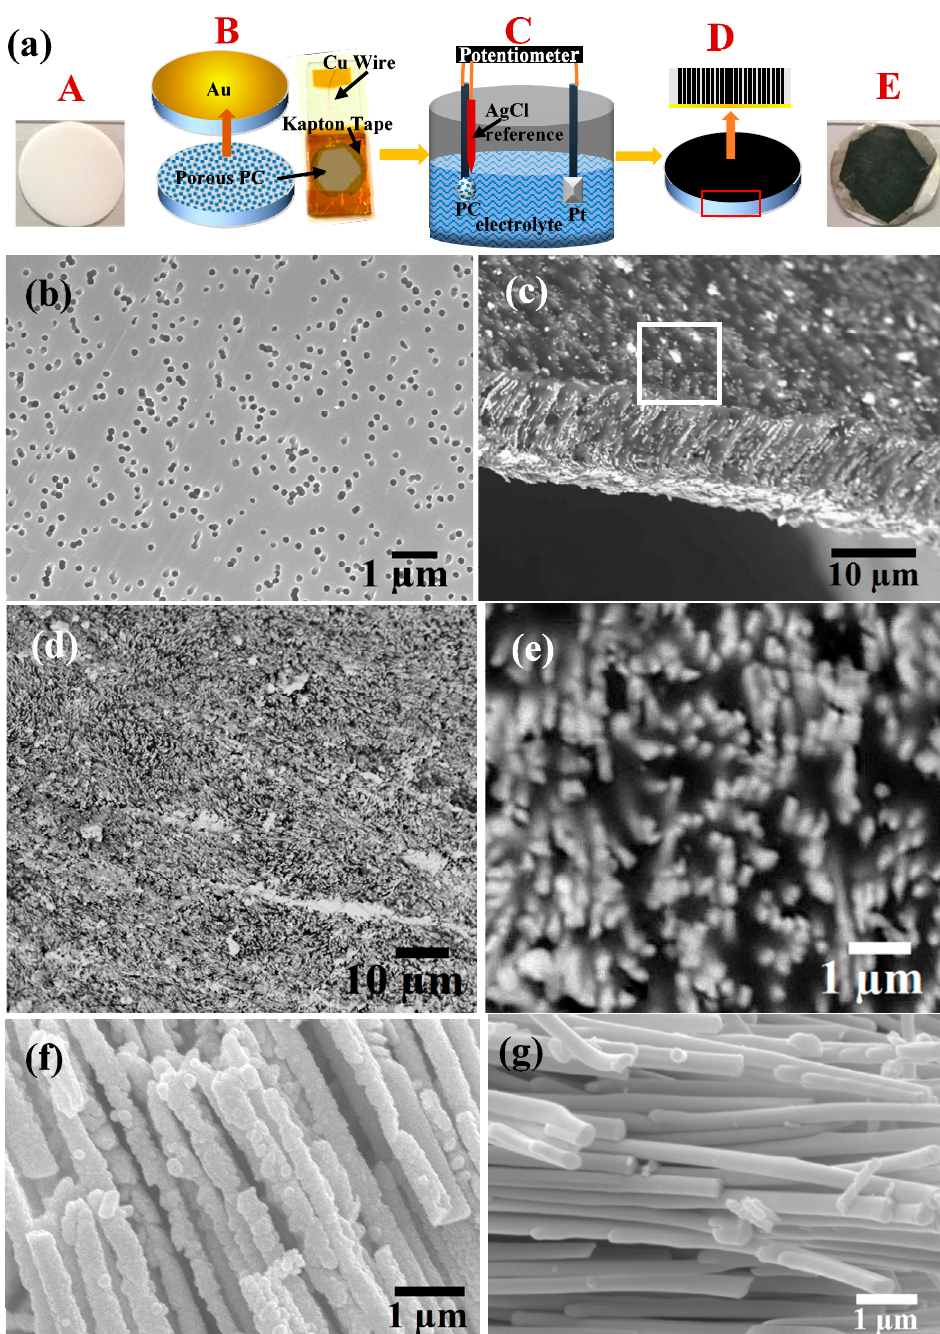
Figure 1. ( a ) Schematic showing the electrodeposition growth process of Bi 2 − x Sb x Te 3 NWs inside polymer PC templates. Panel A is the original PC template and panel E is the template after deposition containing NWs; ( b , c ) are the SEM images of nanoporous PC templates before and after NW growth; ( d ) shows the surface of the NW filled template as indicated in ( c ) (white square); ( e ) Close-up view of the NW arrays inside the PC template; ( f ) Sb-rich Bi 2 − x Sb x Te 3 NWs after dissolving PC template which show rough surfaces as compared to the Bi-rich NWs as shown in ( g ) which are smooth textured.